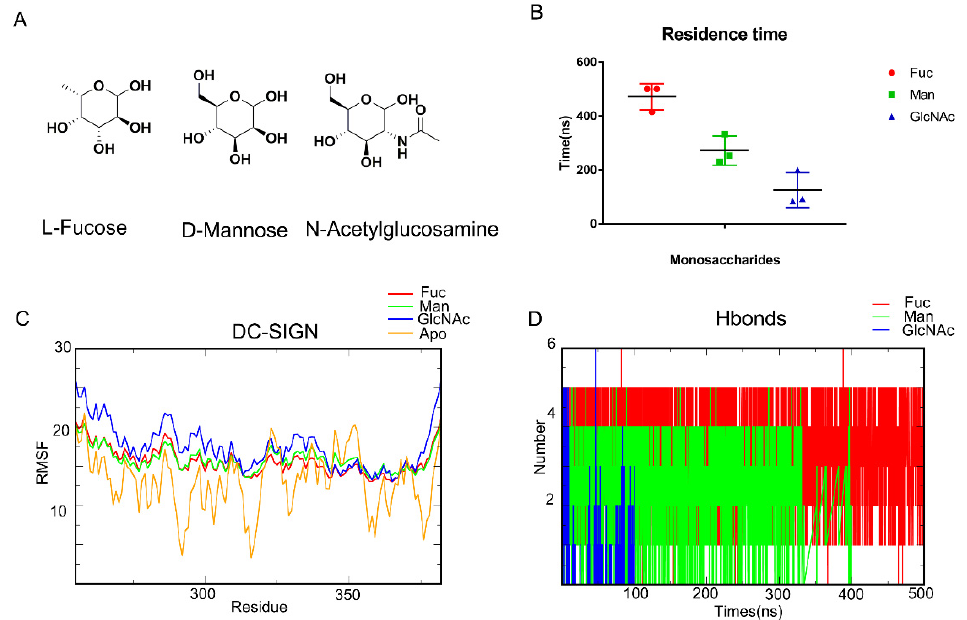
Figure 1. MD simulations demonstrate the recognition of DC-SIGN and monosaccharides. ( A ) L-Fucose , D-mannose , N-acetylglucosamine . ( B ) RMSD about each complex, the Fuc-DC-SIGN last for 500 ns. GlcNAc for the least. ( C ) RMSF of DC-SIGN along Fuc, Man, GlcNAc and Apo trajectories. Bound with monosaccharides would enhance the stability of the loop from Arg344 to Val351. ( D ) Number of Hydrogen bonds in each system. L-Fucose bind with DC-SIGN with the most hydrogen bonds. L-Fucose in red, D-Mannose in green, N-acetylglucosamine in blue. Table 1. The MM-GBSA of three monosaccharides binding with DC-SIGN.